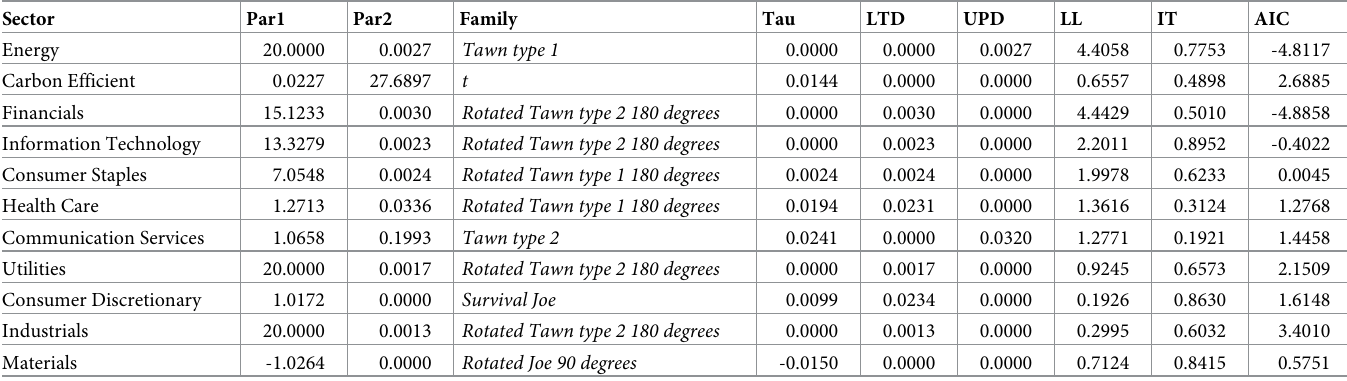
Table 6. Copula results during the Pre-COVID-19 period.